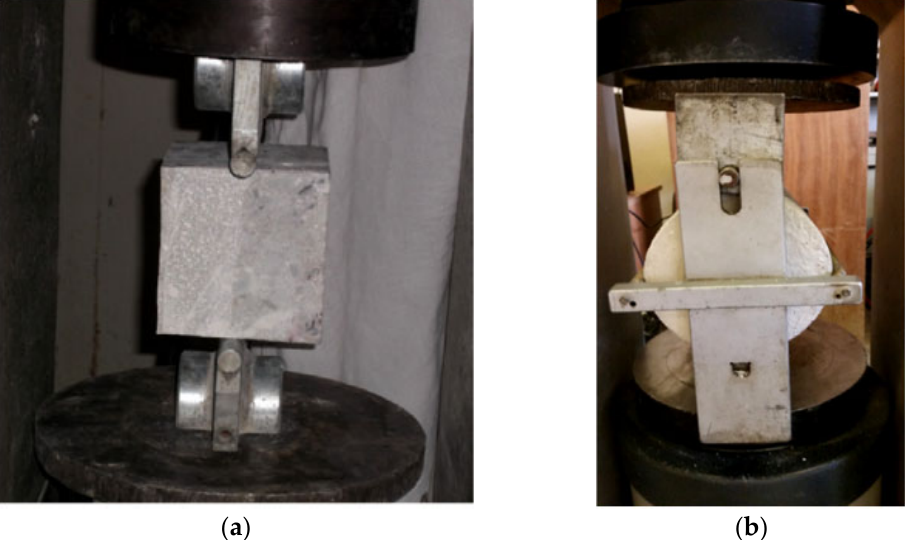
Figure 6. Tests for spilt bond strength between repair materials and concrete substrate. ( a ) cube specimen; ( b ) cylinder specimen [60]. (Adapted and reprinted with permission from ref. 60, © 2017, Construction and Building Materials .).